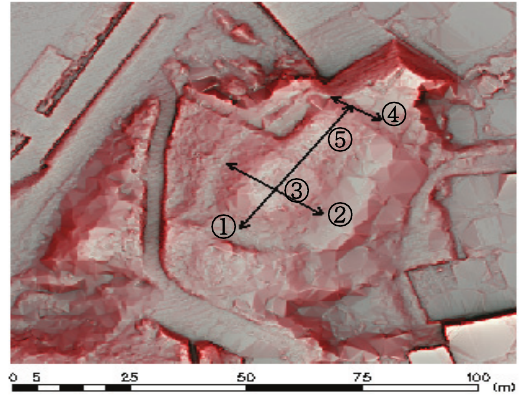
Fig12. A New keyhole-shape mounded tomb (RRIM of Lidar) Table 2. Length of a new keyhole-shape mounded tomb